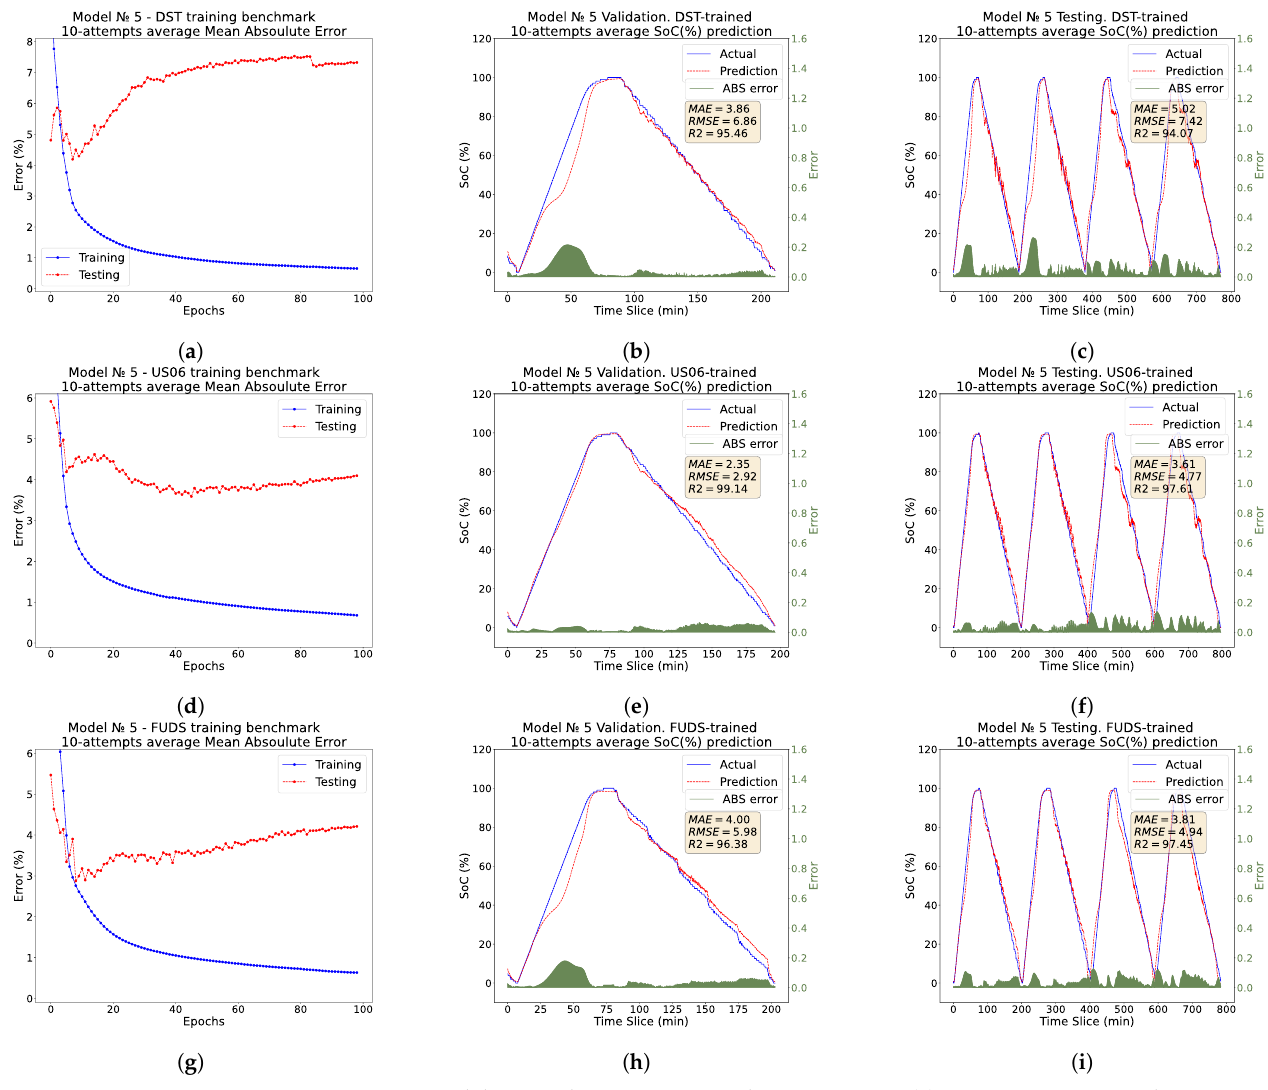
Figure 18. Model 5: stateless LSTM—simplest optimisers. ( a ) Average training and testing MAE history; average of 10 attempts with a higher Y-axis. b ) Validation on a single cycle of SoC estimation; average of 10 attempts at 25 °C. ( c ) Testing on two cycles of US06 and FUDS profiles; average of 10 attempts. ( d ) Average training and testing MAE history; average of 10 attempts. ( e ) Validation on a single cycle of SoC estimation; average of 10 attempts at 25 °C. ( f ) Testing on two cycles of DST and FUDS profiles; average of 10 attempts. ( g ) Average training and testing MAE history; average of 10 attempts. ( h ) Validation on a single cycle of SoC estimation; average of 10 attempts at 25 °C. ( i ) Testing on two cycles of DST and US06 profiles; average of 10